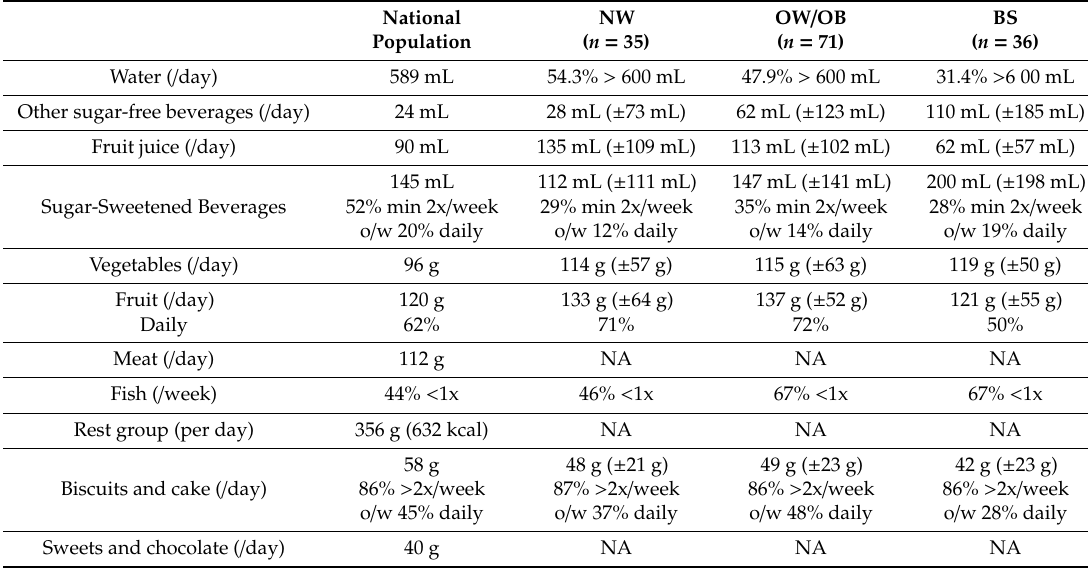
Table 2. Overview of average nutritional consumption for the Belgian population (children 6–9 years old) [24] and our study groups.